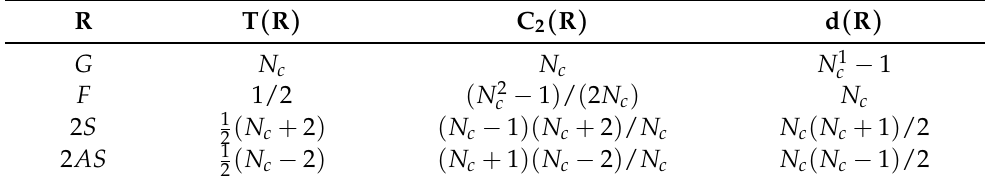
Table 1. The group theory factors for adjoint, fundamental and two-index (anti)symmetric represen- tations of SU( N c ) . The last column gives the dimension of the representation.